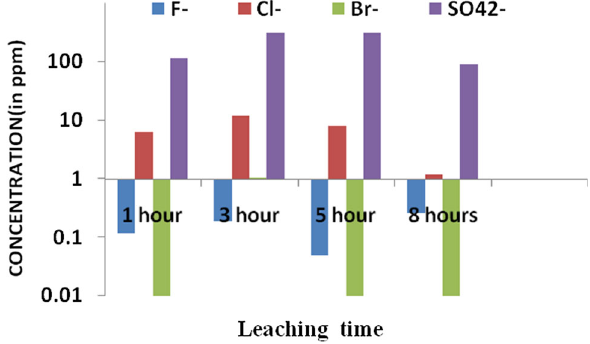
Fig. 14 Change in concentration (in ppm) of anions in aqueous leachates of Ledo overburden (LOB-15B) with leaching time (in hour) at 25 (cid:3) C